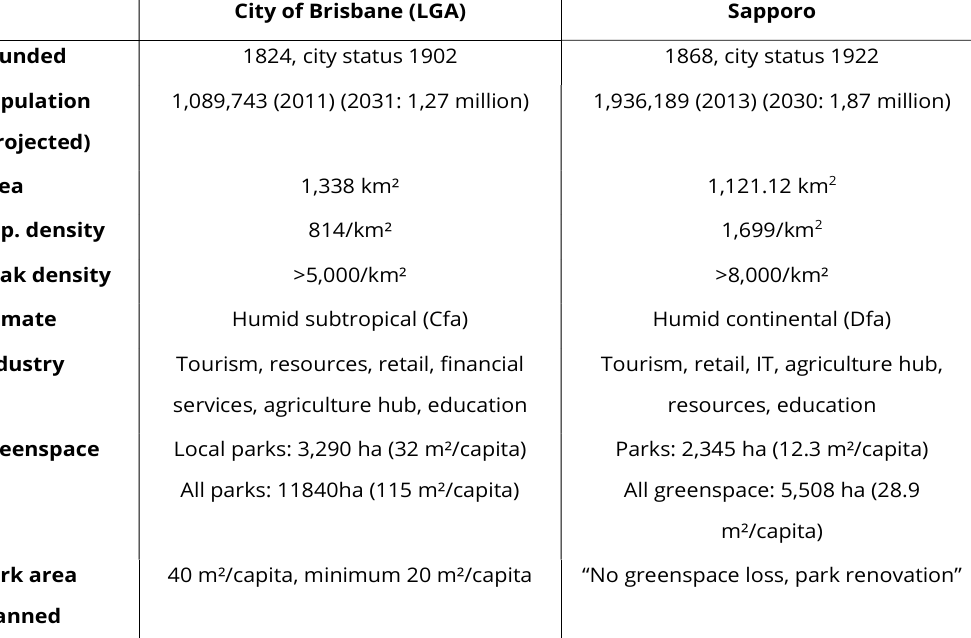
Table 1. Comparison of cities selected for case study (adopted from Rupprecht & Byrne